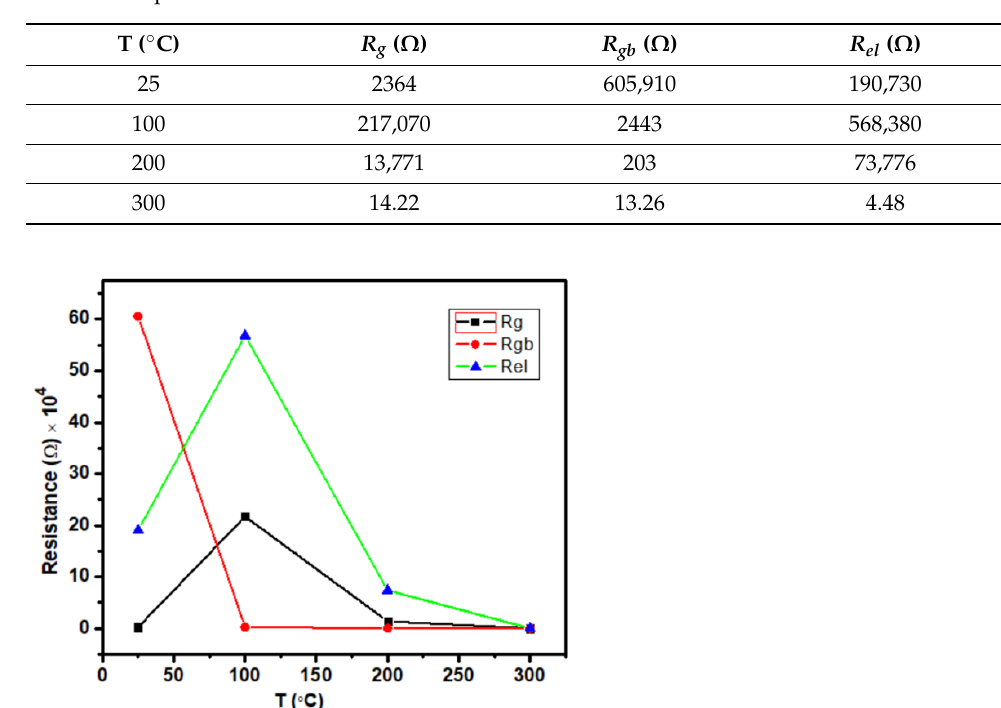
Table 2. Grain ( R g ), grain boundary ( R gb ), and electrode–material interface (R el ) contributions at different temperatures.